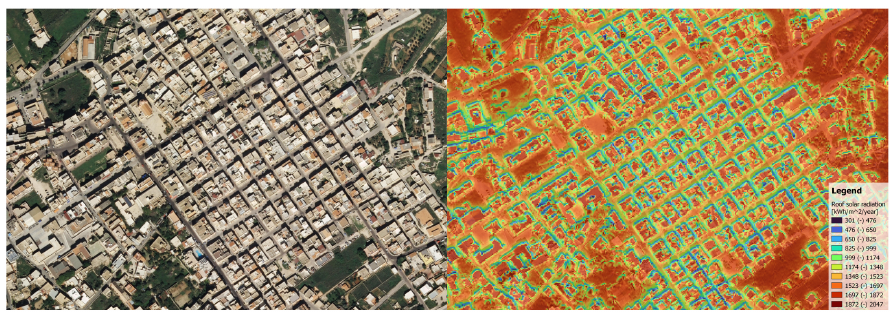
Figure 13. Total irradiance at ground level and on roofs. The resulting grid, displayed in QGIS Map Canvas, shows the theoretical potential as previously